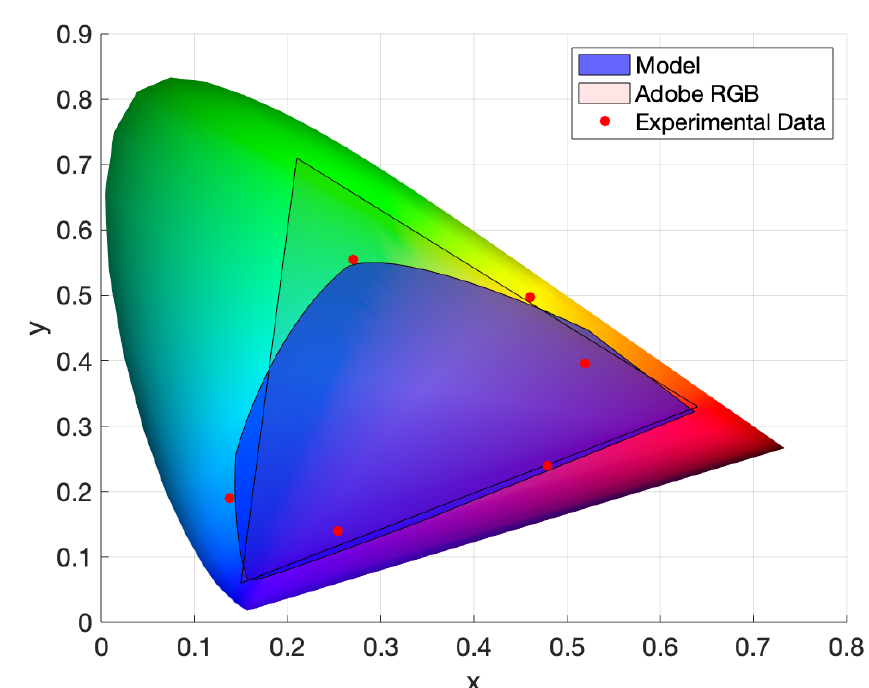
Figure 14. The predicted colour space from the model fitting. This shows the bounds on the x and y values and the colours we can produce, using the ink formulation in Figure 11 and restricting each component layer to a plate range of 0 to 1 mm. Note that these inks hold a much larger colour gamut than those in Figure 7. The Adobe RGB colour space that represents the colour space possible for a generic CMYK inkjet print is given as a comparison. The solid red markers display the x and y values obtained from experimental data for single and double prints, displaying the highest print height and therefore “strongest” version of that